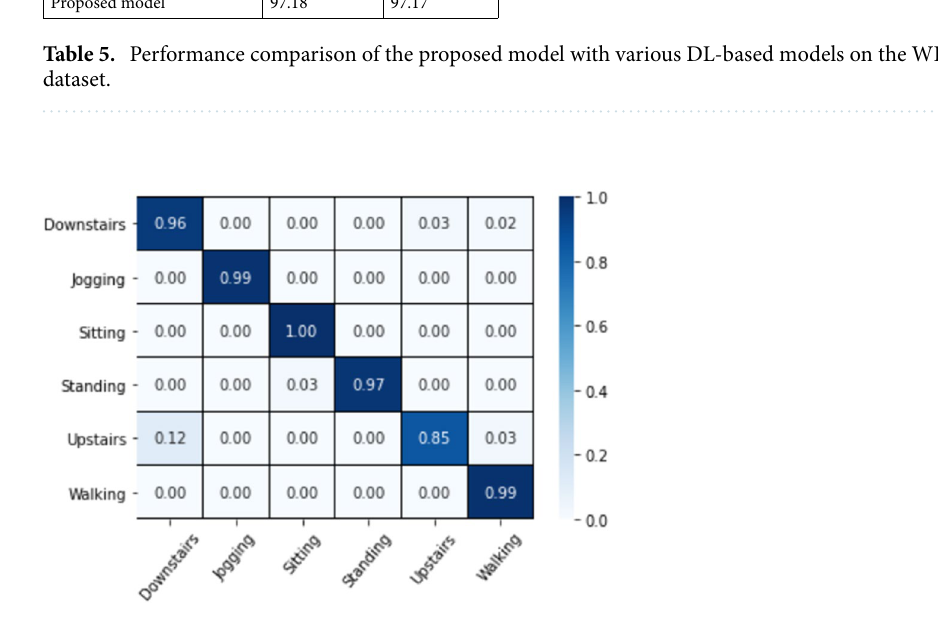
Figure 4. Confusion matrices for the proposed model on the WISDM